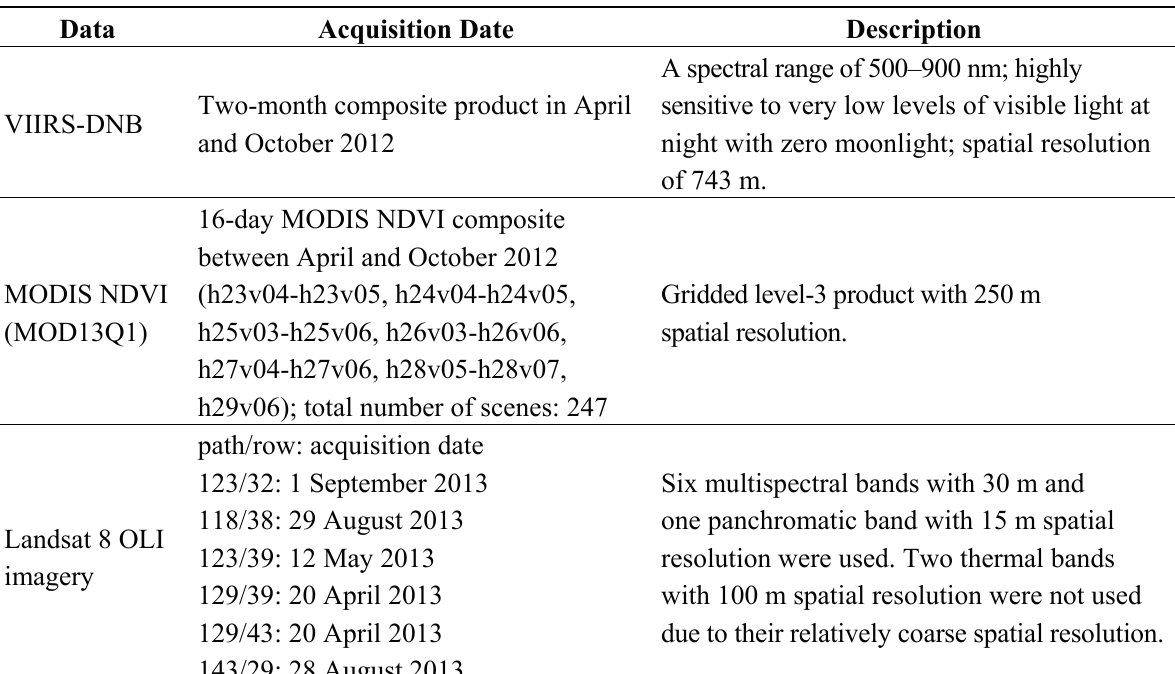
Table 2. Remote sensing data used in